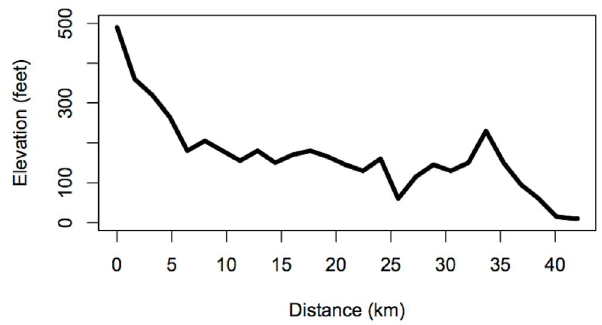
Figure 1. Elevation profile of the Boston Marathon course.